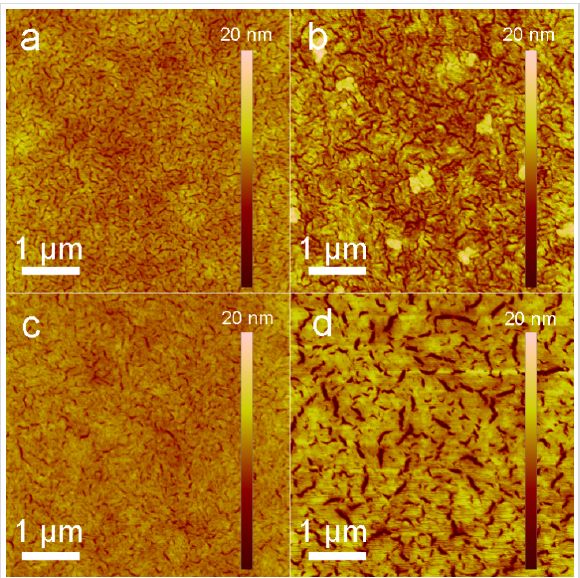
Figure 4: AFM height images of COOP- n HT-TBDT:PC61BM blended films: (a) 1 , 1:0.6 (w/w); (b) 2 , 1:0.6 (w/w); (c) 3 , 1:0.4 (w/w); (d) 4 , 1:0.4 (w/w).